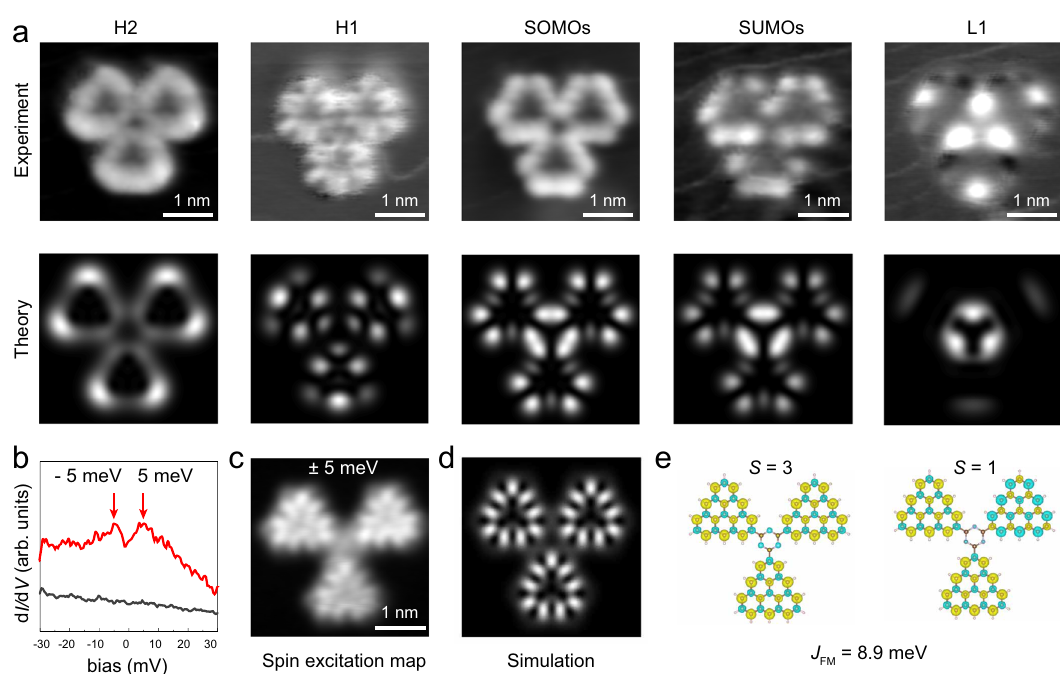
Fig. 5 Experimental and simulated d I /d V maps of Tt. a Constant-current d I /d V maps (top) and theoretical simulated maps (bottom) at energies of − 2.3 V (H2), − 1.8 V (H1), − 0.5 V (SOMOs), 1.35 V (SUMOs) and 2 V (L1). ( V = 25 mV, I = 200 pA). b Low-energy d I /d V spectra on Tt. c , d Constant- rms height d I /d V map ( c ) and theoretical simulated map ( d ). e DFT-calculated spin density distribution of Tt in spin state of S = 3 and S = 1. The colors green and yellow represent the spin density distributions. Set point: ( b ) V = 30 mV, I = 200 pA; ( c ) V rms = 2